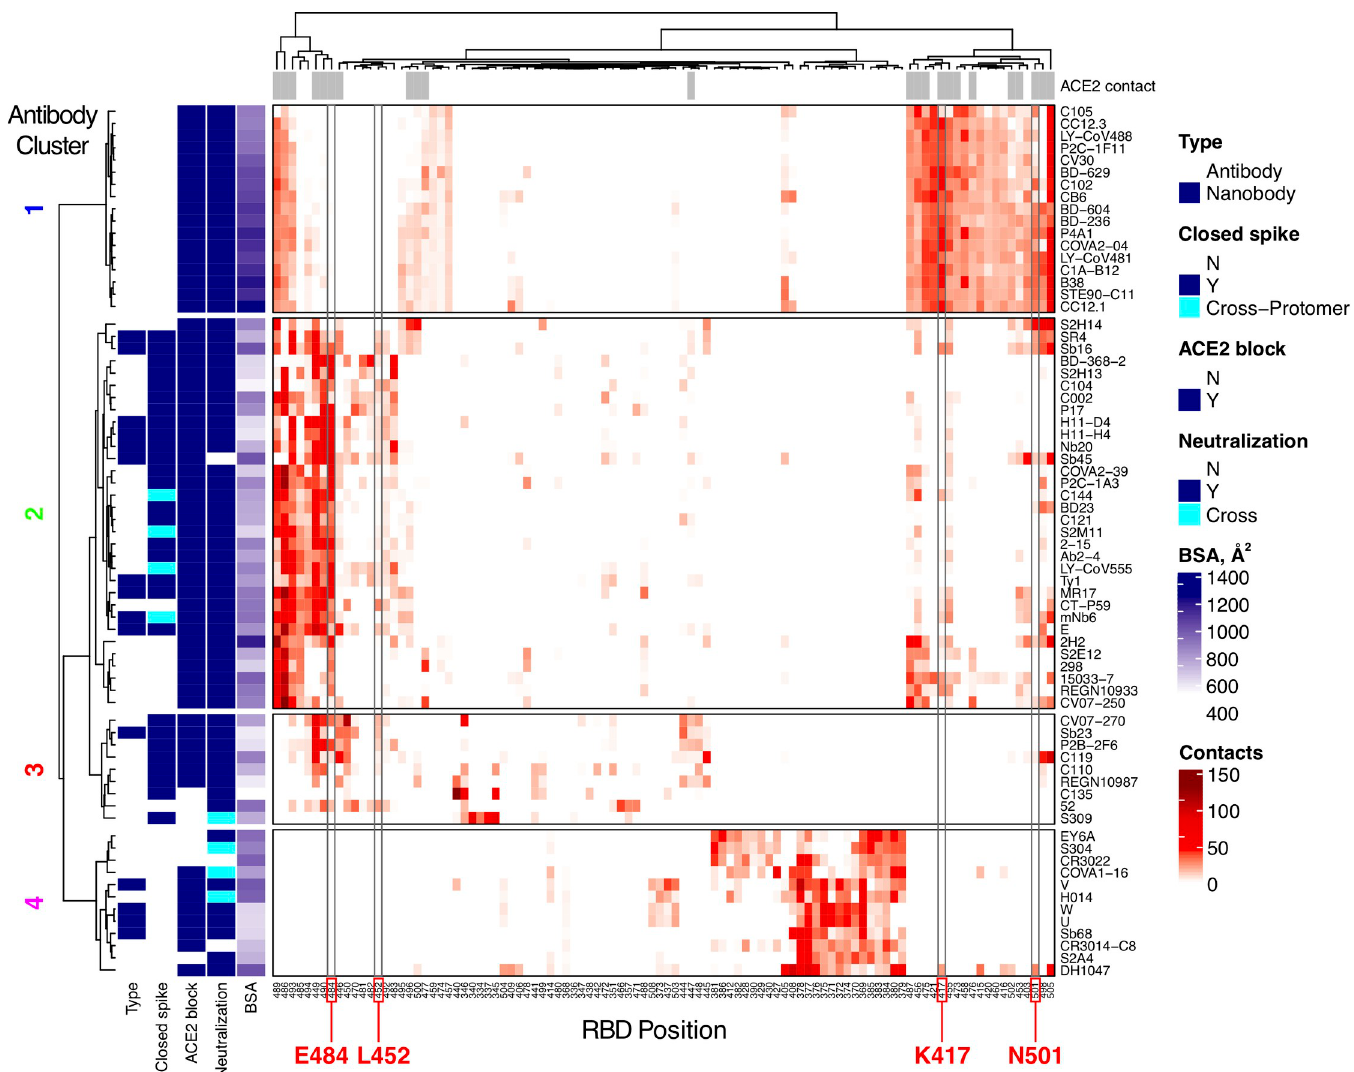
Fig 2. High resolution mapping and clustering of SARS-CoV-2 RBD antibody binding. RBD residue contact profiles were generated for each antibody based on number of antibody atomic contacts for each RBD residue within a 5 Å distance cutoff. RBD residues and antibodies are ordered using hierarchical clustering analysis, with dendrograms shown on top and left. The antibodies are separated into four major clusters based on contact profiles, and cluster numbers (1–4) are indicated on left. Contacts in heatmap are colored by number of RBD residue antibody atomic contacts, as indicated in the key. For reference, antibody type (Antibody: heavy-chain antibody, Nanobody: single-chain antibody), binding to RBD-closed spike conformation (Closed spike), ability to block ACE2 binding (ACE2 block), SARS-CoV-2 neutralization or SARS-CoV-2/SARS-CoV-1 cross-neutralization (“Y” and “Cross”, respectively, under Neutralization), and interface buried surface area (BSA, Å 2 ) are shown on the left sidebars. Closed spike binding and ACE2 blocking were calculated based on the structures, as described in the Methods. The top bar above the heatmap indicates RBD residues contacted by ACE2 (5 Å distance cutoff) in an ACE2-RBD complex structure (PDB code 6LZG) [52]. For clarity, 100 RBD residues are shown in heatmap; a heatmap with the full set of 139 contacted RBD residues which was used to cluster the antibodies in this figure is shown in S2 Fig . RBD residues that are mutated in SARS-CoV-2 variants of concern (K417, L452, E484, N501) are labeled at bottom and highlighted with gray boxes in heatmap.